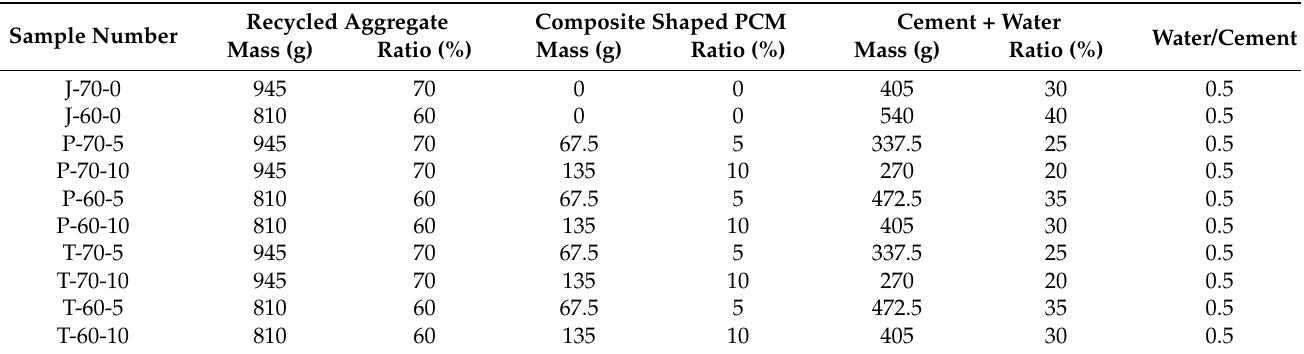
Table 3. Mix proportion of composite shaped PCM recycled aggregate pavement bricks